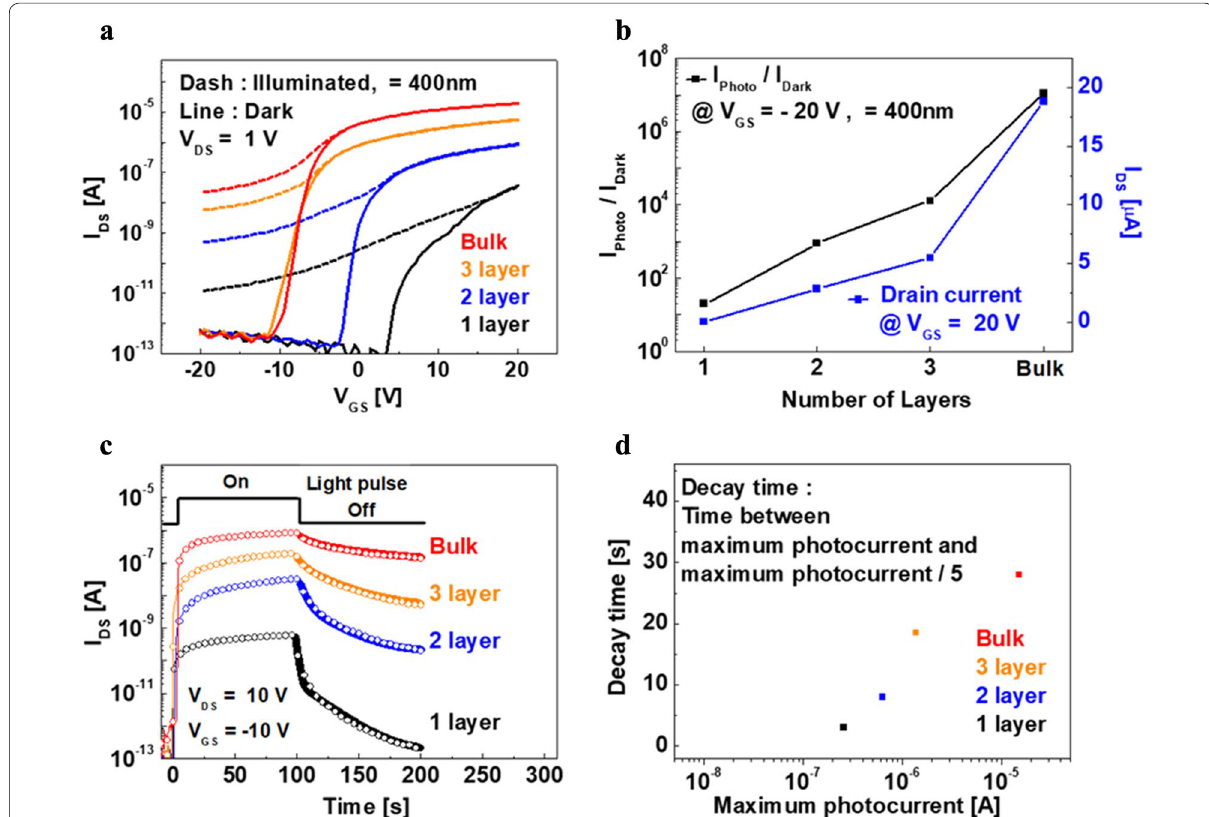
Fig. 2 a I DS –V GS characteristics under dark and illuminated conditions (λ side axis) at V GS 20 V and I DS (right side axis) at V GS 20 V, c dynamic photosensitivity under pulsed illumination, and d decay time and maximum = − photocurrent (obtained from Fig. 4.2c) of MoS 2 photo-TFT samples with different numbers of MoS 2